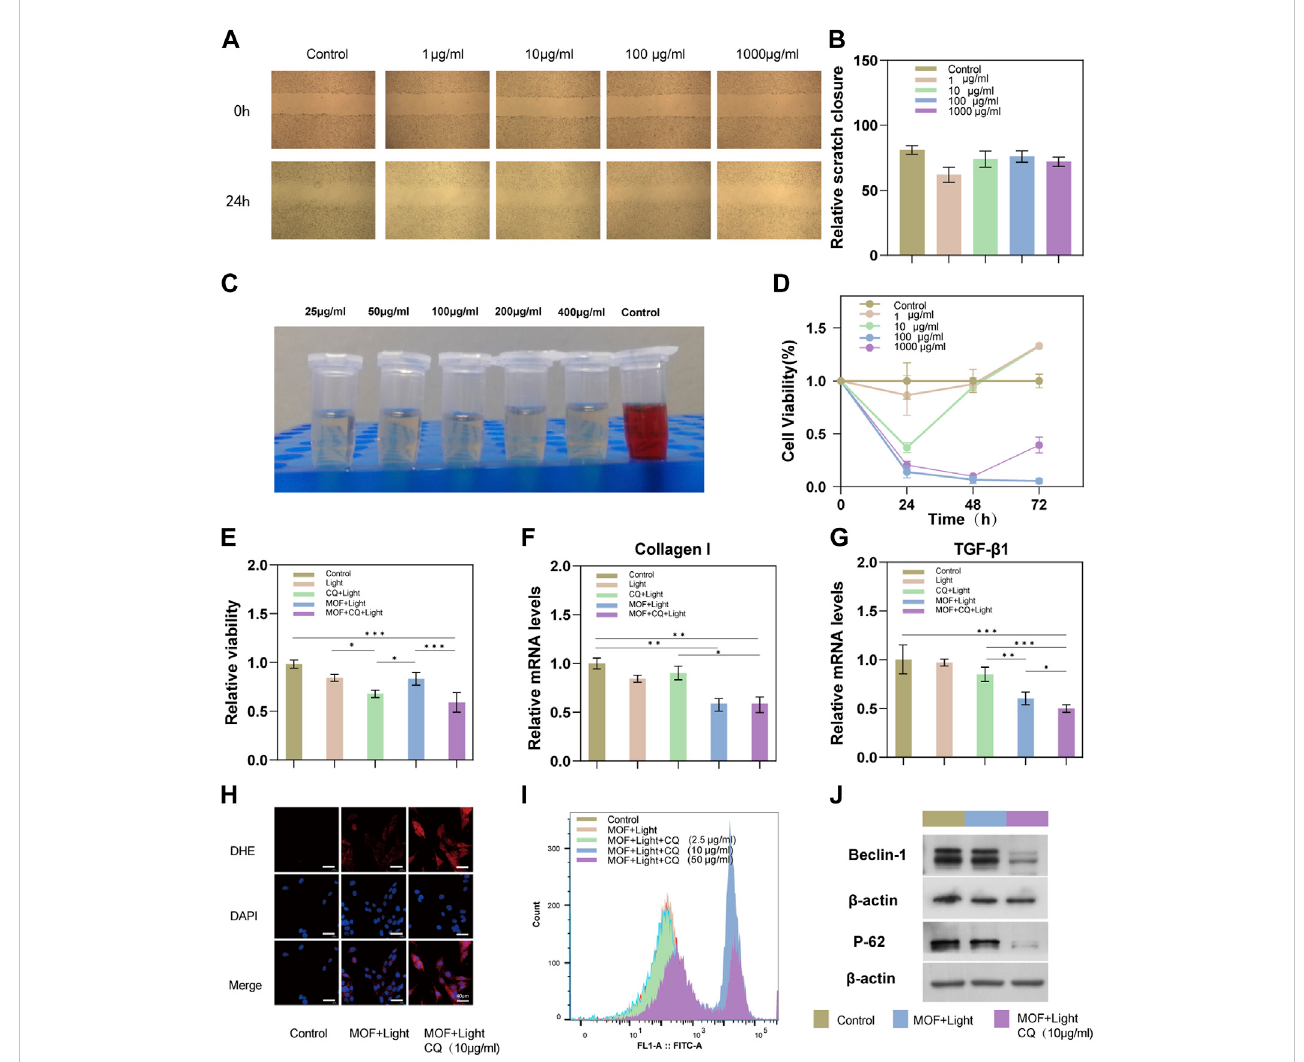
FIGURE 2 Biocompatibility and PDT therapeutic ef fi cacy of MOFs (CuO x @MIL-101). (A) Scratch-wound assay to evaluate the migration of HSFs treated with different concentrations of MOFs. (B) Quanti fi cation of scratch wound closure after 24 h treatment. (C) Hemolysis assays were conducted to evaluate the safety of MOFs in different concentrations (25, 50, 100, 200, and 400 μ g mL − 1 ). (D) Viability of HSFs after treatment with different concentrations of MOFs for 24, 48, and 72 h. (E) Viability of HSFs after treatment with Light, CQ + MOFs, MOFs + Light, and MOFs + Light + CQ for 24 h. (F, G) Relative mRNA expressions of TGF- β 1 and collagen I inHSFs treated by Light, CQ + MOF, MOFs + Light, and MOFs + Light + CQ for 24 h. (H) Intracellular ROS was measured usingROS FluorescentProbe-dihydroethidium(DHE) (scalebar:40 μ m) (I) ROSproduction wasmeasuredwith the fl owcytometricanalysis.(n=3, * P < 0.05; ** P < 0.01; *** P < 0.001). (J) Western blotting assay was carried out to detect expression levels of autophagy-related proteins (Beclin 1, and